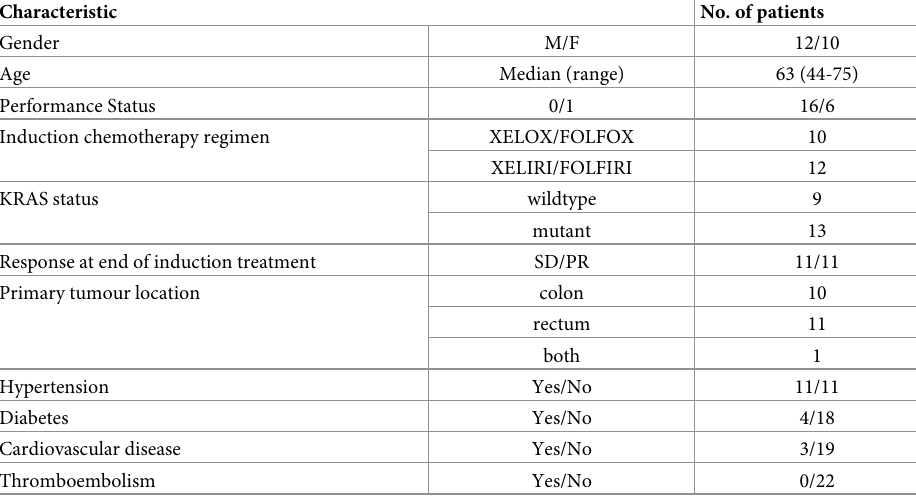
Table 2. Patient baseline characteristics of the protein array cohort